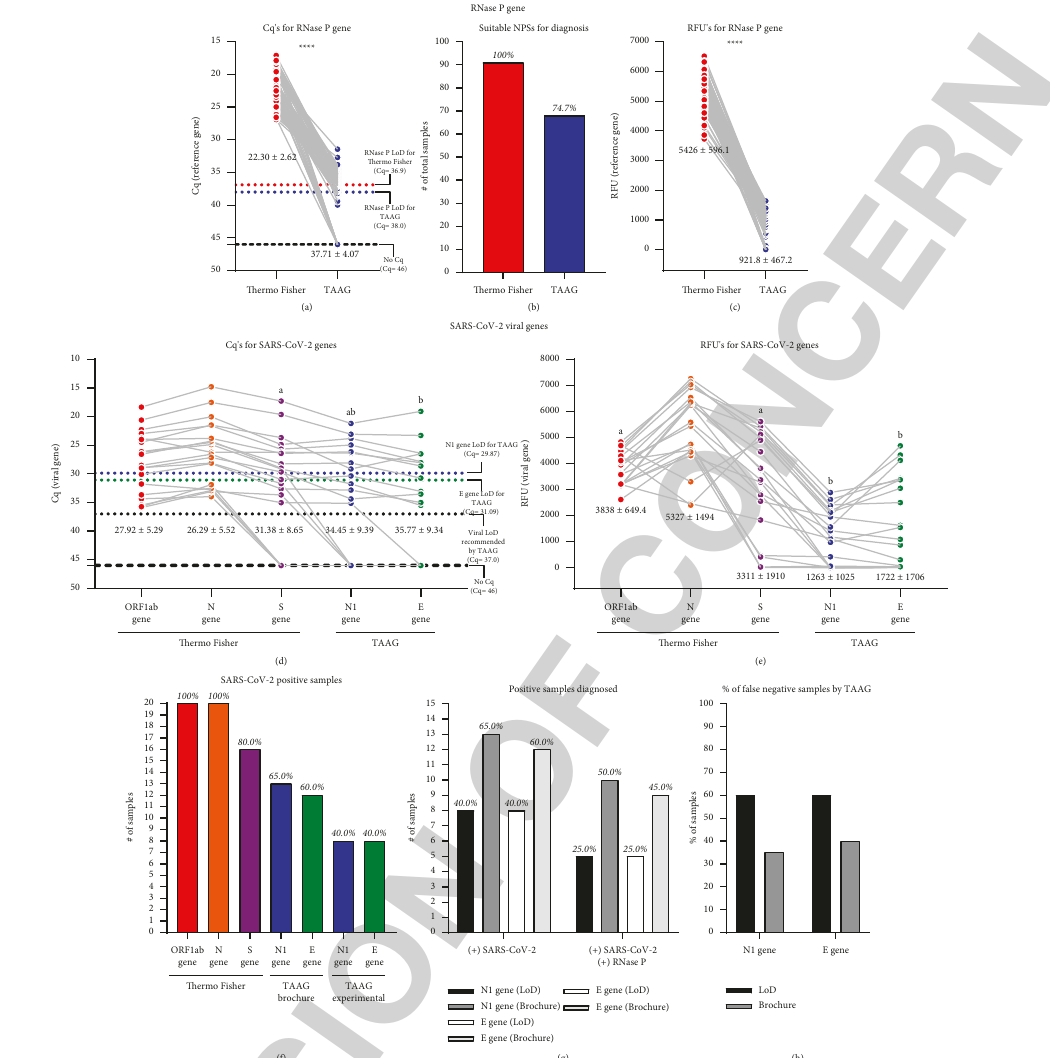
Figure 2: Comparative analysis for the detection of SARS-CoV-2 from random-chosen nasopharyngeal swab samples (NPSs) using Thermo Fisher and TAAG RT-qPCR kits. The comparison was made from the same NPSs using the previously optimized volume of 2 μ l of total RNA extracted. The upper section of the figure represents the analysis for the amplification of RNase P internal reference gene probes from 91 random NPSs.(a)Cq value forinternal reference RNase P geneprobe amplification usingThermo Fisherand TAAGRT-qPCR kits( n � 91 NPSs).Ingraph, the horizontal red-dotted line represents the LoD for RNase P reference gene probe (Cq � 36.9) by Thermo Fisher kit, and the horizontal blue- dotted line represents the maximum recommended Cq value (Cq � 38) by the manufacturer of suitable sample for diagnosis using TAAG RT- qPCR kit RNase P reference gene probe. Samples with Cq � 46 denote no amplification (indicated in the graph by a black broken line). (b) Summary of the percentage of suitable NPSs for diagnosis using the internal reference RNase P gene probe (detailed on (a)) by both RT-qPCR kits. (c) RFU value from the same samples analyzed on (a). Samples with a Cq value > 38 were considered as not suitable according to manufacturer’s recommendations. For statistical analysis, a paired two-sided student’s t -test was applied ( n � 91 random NPSs, ∗∗∗∗ p < 0 . 05). The lower section of the figure represents the analysis for the amplification of SARS-CoV-2 viral gene probes from 91 random NPSs. Paired comparison for (d) Cq and (e) RFU values from viral gene probe amplification using Thermo Fisher (ORF1ab, N, and S gene probes) and TAAG (N1 and E gene probes) kits ( n � 20). In graph (d), the horizontal colored-dotted lines blue and green, respectively, represent the experimental LoD for N1 gene (Cq � 29.87) and E gene (Cq � 31.09) probes of TAAG RT-qPCR kit. The horizontal black dotted line represents the maximum Cq value (Cq � 37) rec- ommended by the manufacturer for positive sample diagnosis using TAAG RT-qPCR viral probes. Samples with Cq � 46 denote no amplification (indicated in the graph by a black broken line). For statistical analysis, a paired one-way ANOVA-test with multiple comparison test analysis applied. Lowercase letters above each probe’s spot columns indicate which probes do not show significant differences between them. ( n � 20 NPSs, ∗∗∗∗ p < 0.05).Ingraphs(a),(c),(d), and (e),themean ± standarddeviation (mean ± SD)isindicatedfortheviralgeneprobeamplification obtained for all the samples evaluated. The line linking the spots indicated the paired result obtained for the same sample assessed by both RT-qPCR kits. (f) Summary of the number of positive NPSs detected using Thermo Fisher (ORF1ab, N, and S probes) and TAAG RT-qPCR kit (N1 and E viral gene probes applying brochure or experimental LoD criteria ((n) � 20). (g) Summary of the number of positive NPSs diagnosed using TAAG RT-qPCR kitconsideringtheRNase Pinternalcontrolamplification.Inthegraph,“(+)SARS-CoV-2”represents apositivevirus diagnosis,and “(+)RNaseP” represents the amplification of the internal reference gene. (h) Summary of the percentage of false negative NPSs diagnosed by TAAG RT-qPCR kits applying brochure or experimental LoD